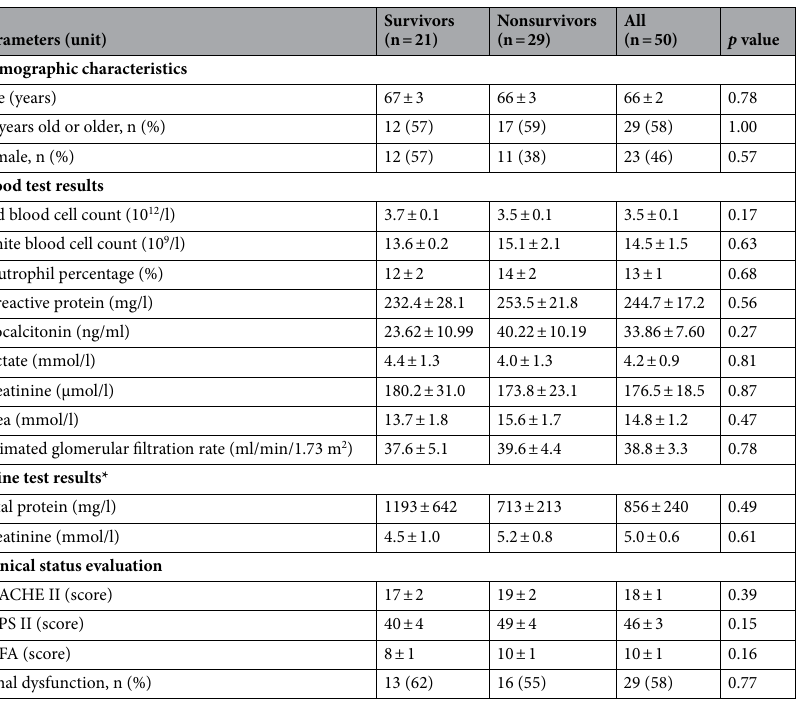
Table 1. Basic demographic data, laboratory parameters, and clinical scores of the survivor and nonsurvivor septic patients on the admission day to the intensive care unit. *urine samples for the present study could not be obtained on the day of admission from 6 patients (1 survivor and 5 nonsurvivors). Data are expressed as mean ± standard error, except for the sex, elderly, and renal dysfunction ratio, where number (and percentage) of patients is shown. APACHE , acute physiology and chronic health evaluation score; SAPS , simplified acute physiology score; SOFA , sequential (sepsis-related) organ failure assessment